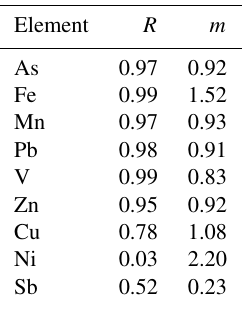
Table 3. Correlation coefficient ( R) and slope ( m in y = mx ) for concentrations measured by laser ablation ICP-MS ( x ) and wet- chemical ICP-MS ( y ) in MOUDI stages 6–10. Reasonable agree- ment was observed for the first six